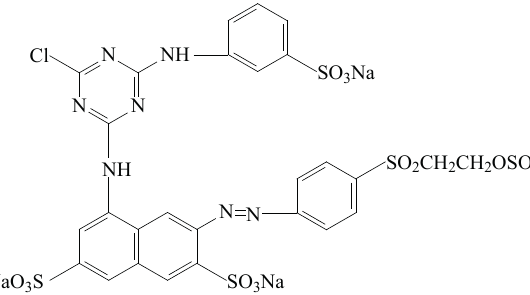
Figure 1: Structure of the reactive red RB